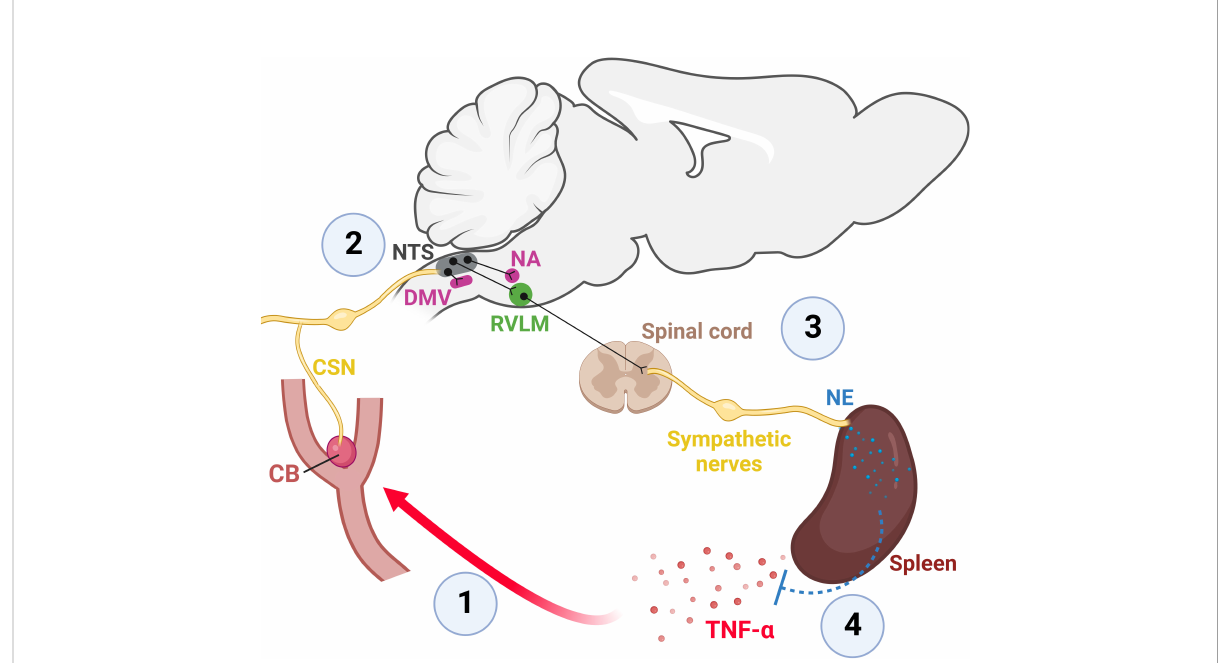
FIGURE 2 The CB is a sensor of peripheral in fl ammation and initiates a sympathetic-mediated anti-in fl ammatory response (26). 1: Elevated levels of TNF- a in the blood depolarizes CB glomus cells which widely express TNF- a receptors type I (26, 71 – 73). Depolarization of CB glomus cells by TNF- a generates action potentials that propagate along axons within the CSN towards the brainstem (26). 2: The fi rst central synapse of CB-originated axons occurs in the NTS, a major integrative brainstem region that receives the sensory information from peripheral organs and projects to several brainstem autonomic areas that control parasympathetic (DMV and NA) and sympathetic (RVLM) functions (32, 41, 46, 50, 52). 3: The TNF- a -induced activation of the CB-NTS-RVLM circuit increases the activity of the splanchnic sympathetic nerve which innervates the celiac ganglia, from where the splenic nerve originates and projects to the spleen, releasing norepinephrine (NE) (26). 4: The release of NE into the spleen reduces both splenic and plasmatic levels of TNF- a (26). CB, carotid body; CSN, carotid sinus nerve; DMV, the dorsal motor nucleus of the vagus; NA, nucleus ambiguus; NTS, nucleus tractus solitarius; NE, norepinephrine; RVLM, rostral ventrolateral medulla; TNF- a , tumor necrosis factor-alpha. Created with